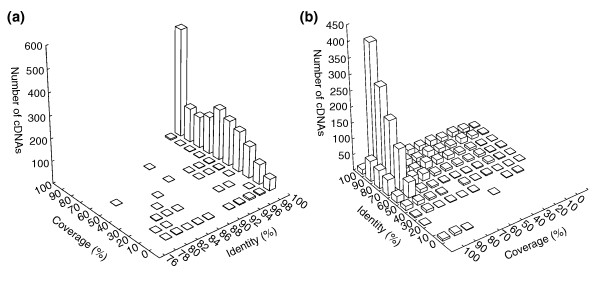
Statistics of BLAST searches. (a) BLASTN search of full-length cDNAs against chicken transcripts predicted by Ensembl. Note that only 494 cDNAs are identical or nearly identical with predicted transcripts. Therefore, the remaining 1,777 experimentally determined full-length cDNAs may be used to improve the gene annotation of chicken genomic DNA. (b) BLASTP searches of annotated ORFs against the UniProt database of protein sequences.